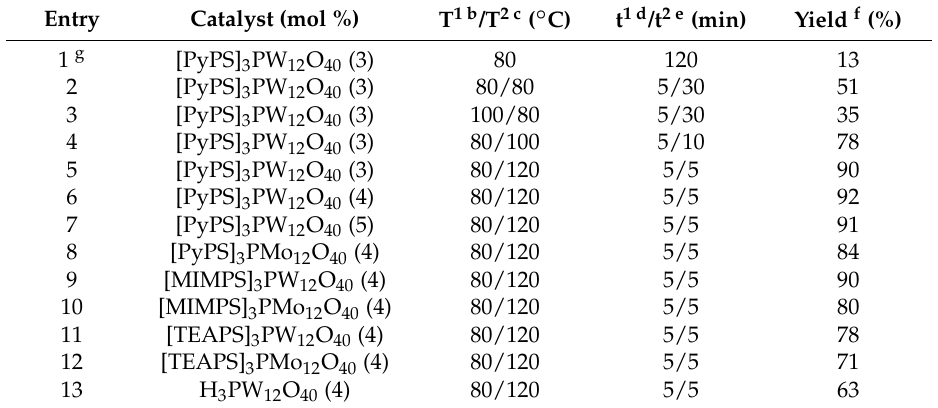
Table 1. Optimization of the reaction conditions for benzyl alcohol, ethylacetoacetate and urea.